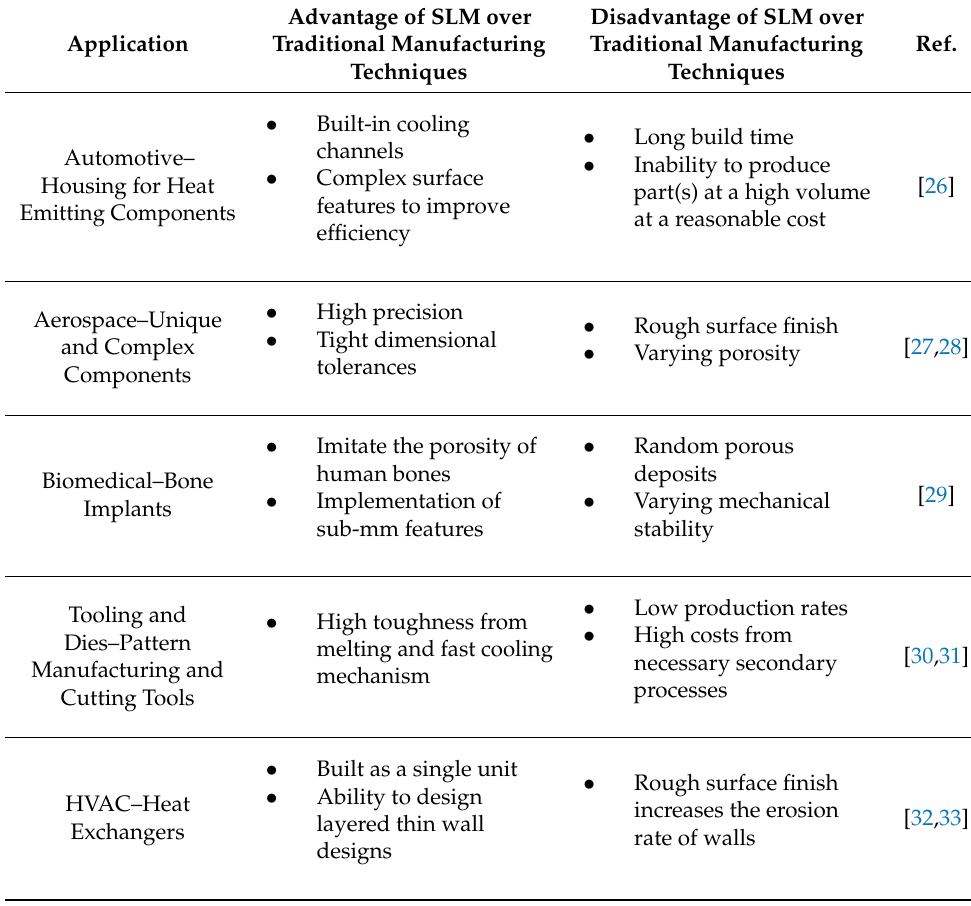
Table 1. Advantages and disadvantages of using SLM over traditional manufacturing